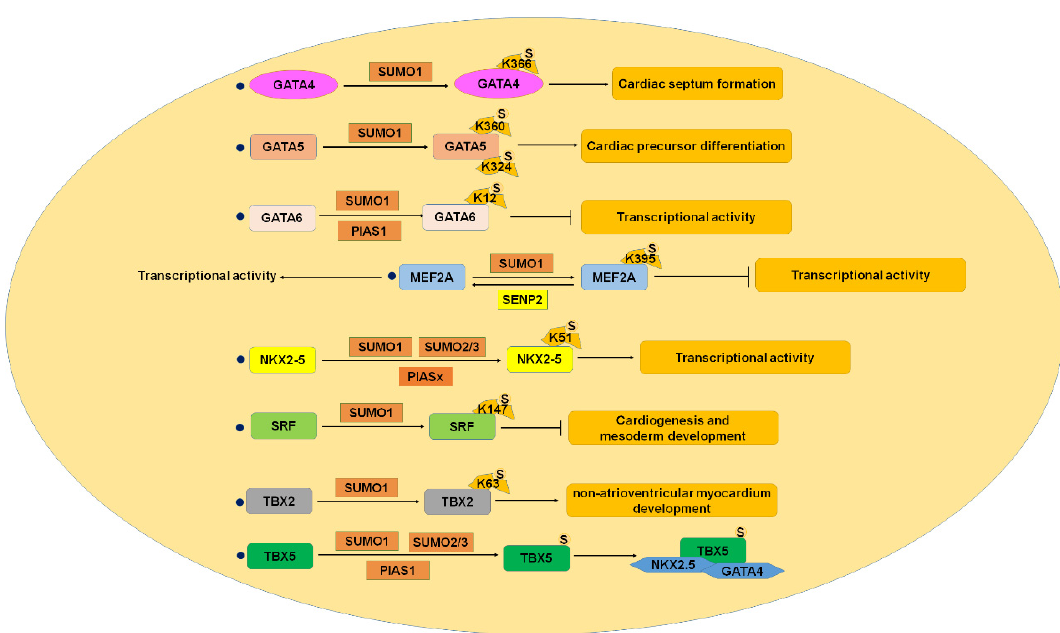
Figure 4. SUMOylation and CHD. GATA4-6, MEF2, NKX2-5, SRF, TBX2, and TBX5 were SUMOylated, and SUMOylation of these proteins played critical roles in cardiac development, whereas imbalance of SUMOylation caused congenital heart disease. CHD, congenital heart disease; MEF2, myocyte enhancer factor 2; SRF, serum responsive factor. S: SUMO.